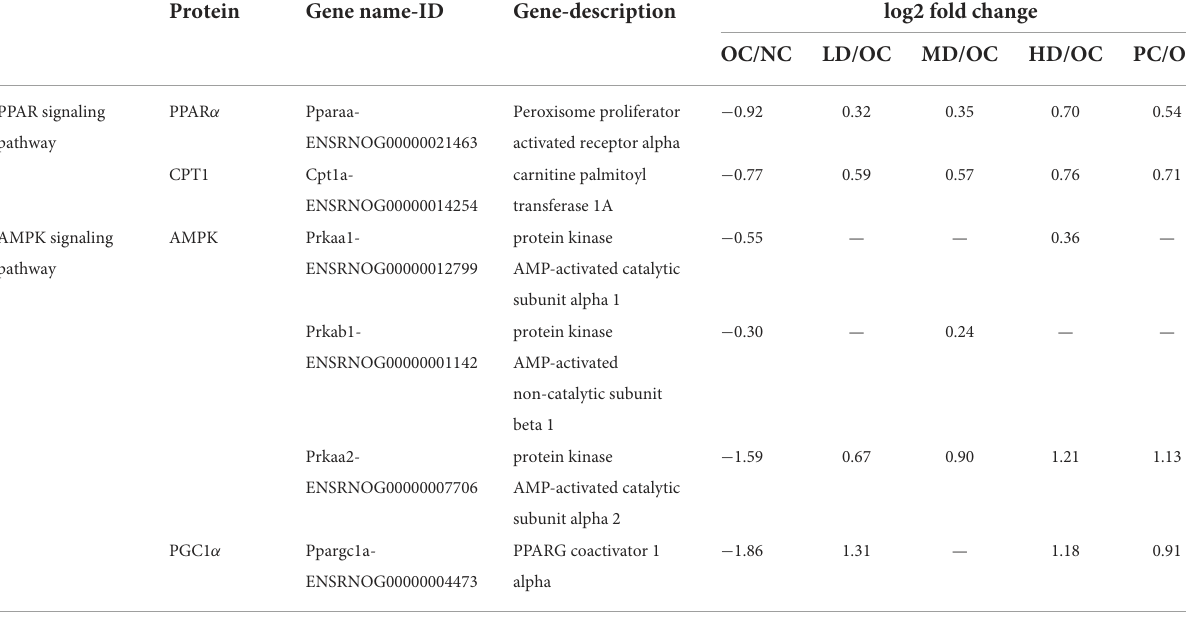
TABLE 5 Expression pattern of differentially expressed genes in PPAR and AMPK signaling